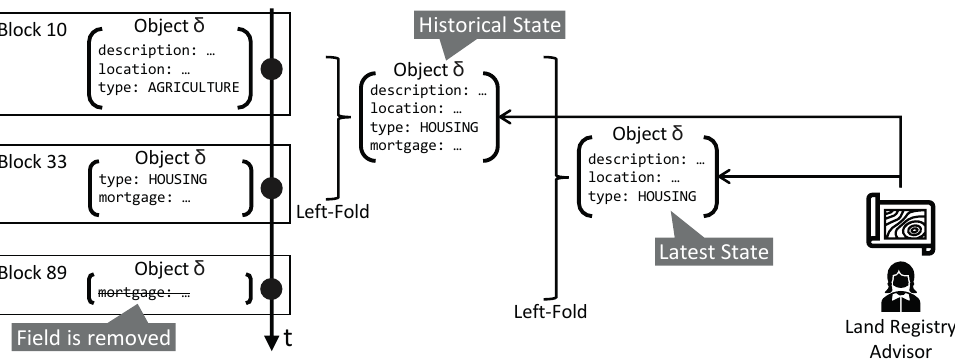
Figure 3. A land registry document, represented as expandable object, which is modified over time. Different states of the document can be retrieved, i.e., the latest state and all historical states. In land registries, land documents are inserted, modified, and deleted over